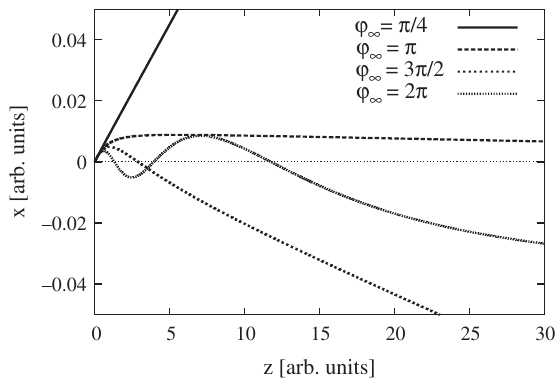
FIG. 1. Example trajectories for various values of the phase